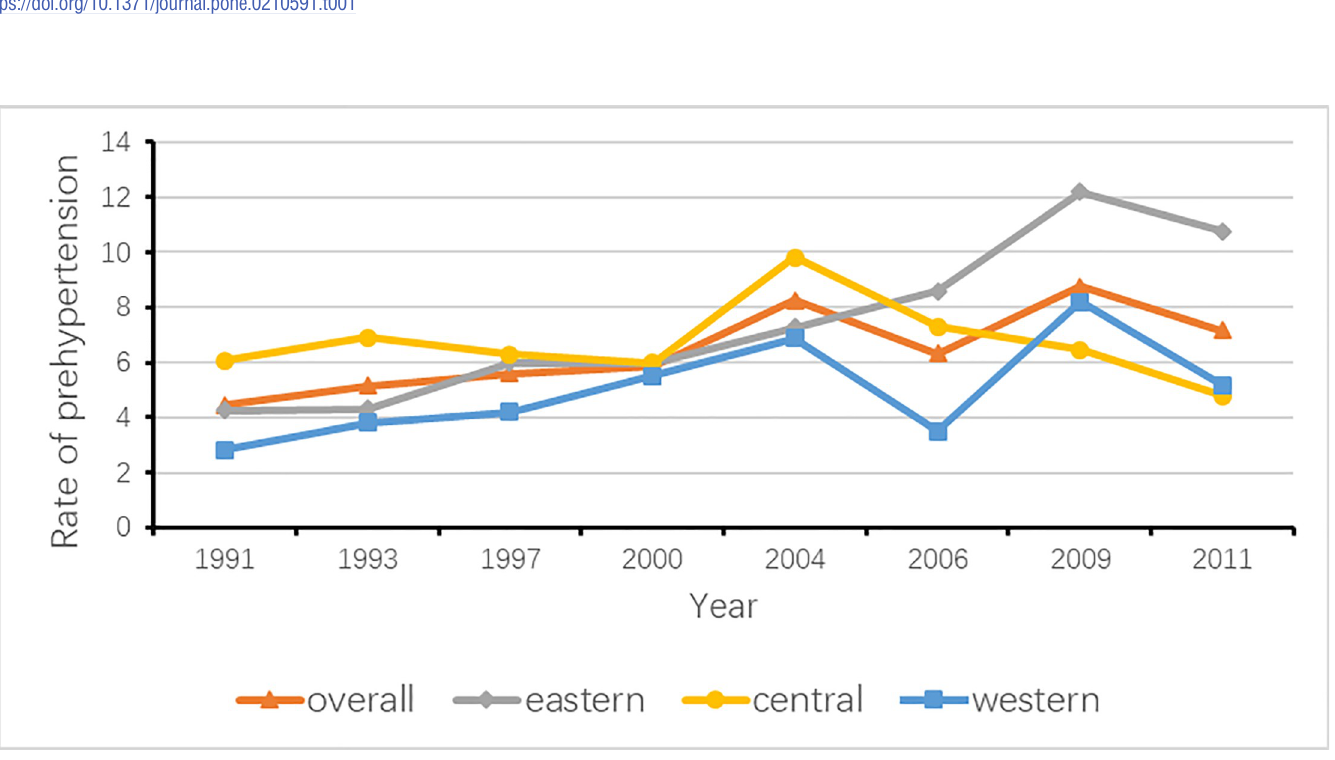
Fig 1. Trends of prehypertension by survey